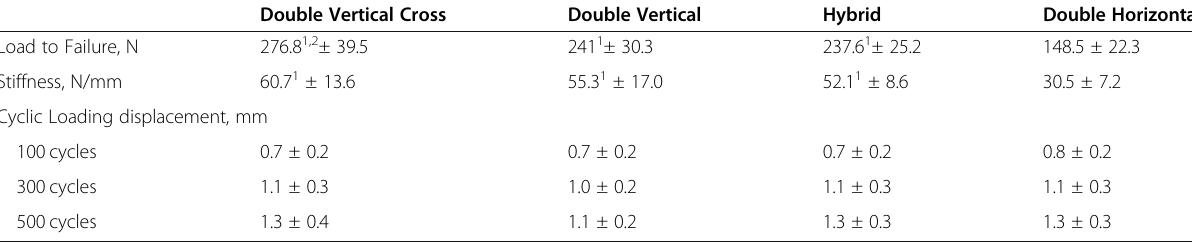
Table 1 Load to failure, stiffness and displacement results for the 4 repair